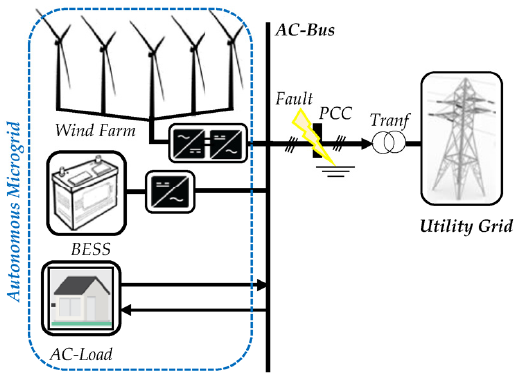
Figure 1. The suggested grid-connected MG architecture.